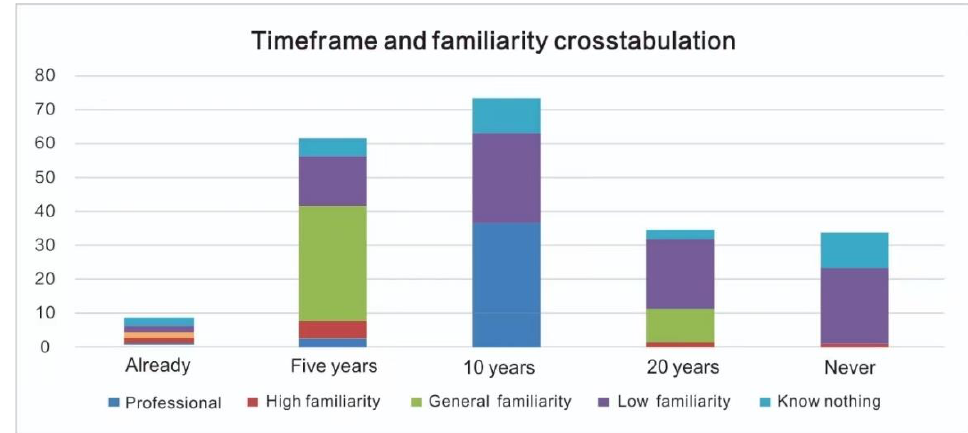
Figure 4. Prospect of commercialization.